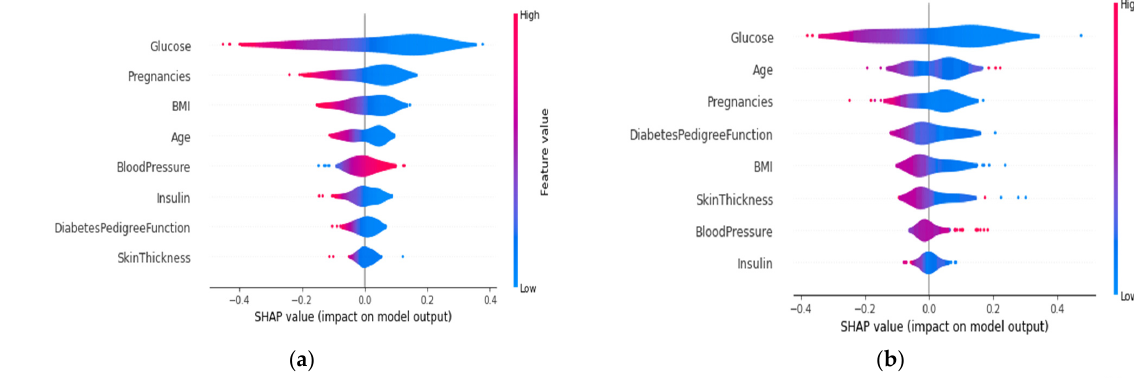
( f ) ( g ) Figure 13. Violin distribution of ( a ) ANN, ( b ) SVM, ( c ) LR, ( d ) RF, ( e ) ADA, ( f ) XGB, and ( g ) Voting classifier.